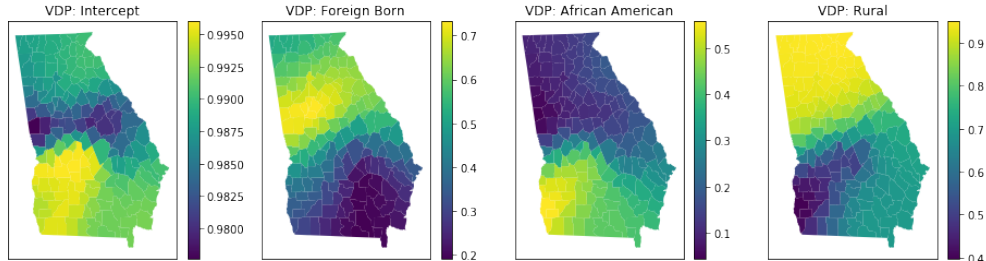
Figure 11. Surfaces of local variance decomposition proportions